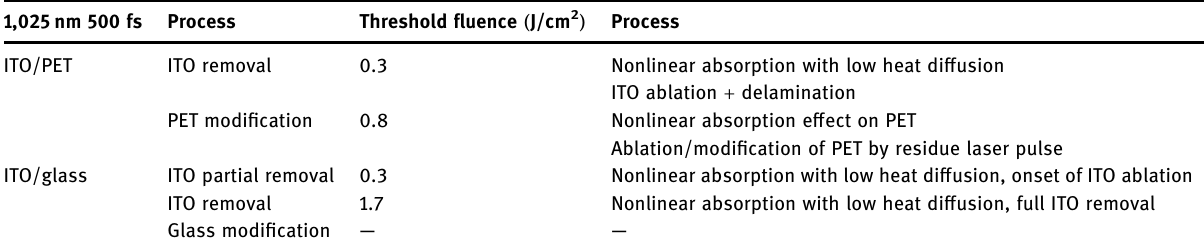
Table 2: Threshold fl uence for fs laser interaction with ITO/PET and ITO/glass 1,025 nm 500 fs